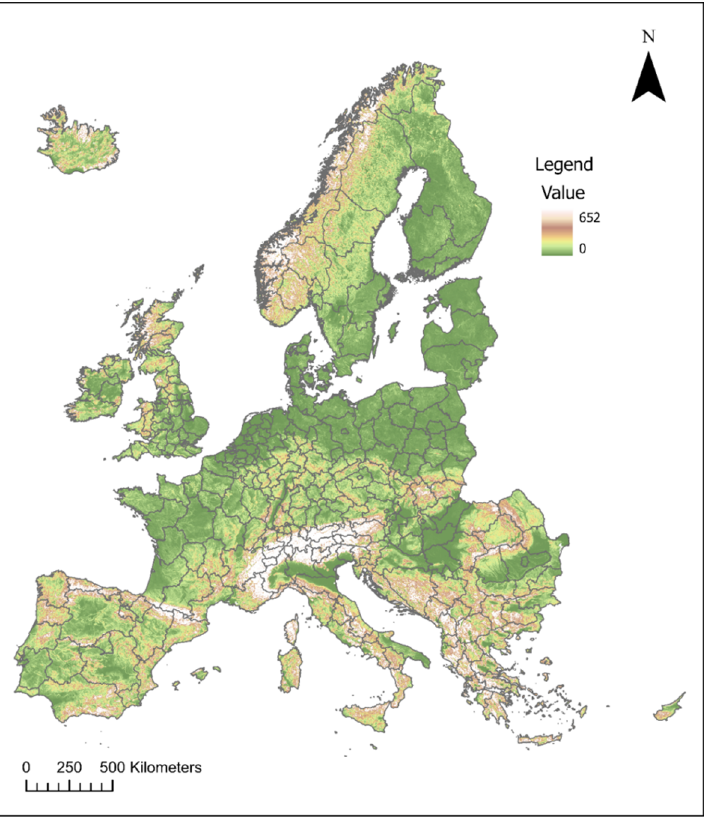
Figure 2. Local relief (standard deviation of elevation in a 1500 m radius) for